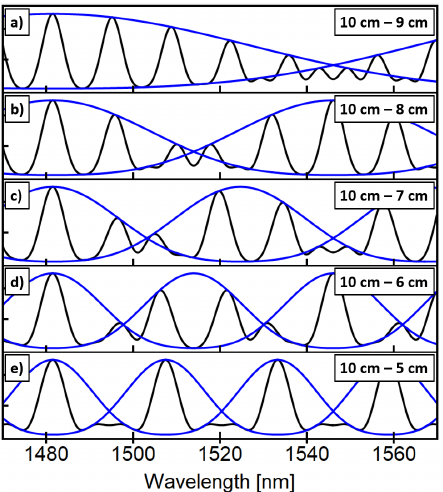
Figure 1. Simulated transmitted spectral response of two cascaded SMF-SCF-SMF with SCF fiber length combinations of ( a ) 10 cm–9 cm, ( b ) 10 cm–8 cm, ( c ) 10 cm–7 cm, ( d ) 10 cm–6 cm, and ( e ) 10 cm–5 cm. The blue curve corresponds to each case’s best fitting envelope of the transmitted spectrum (black curve).